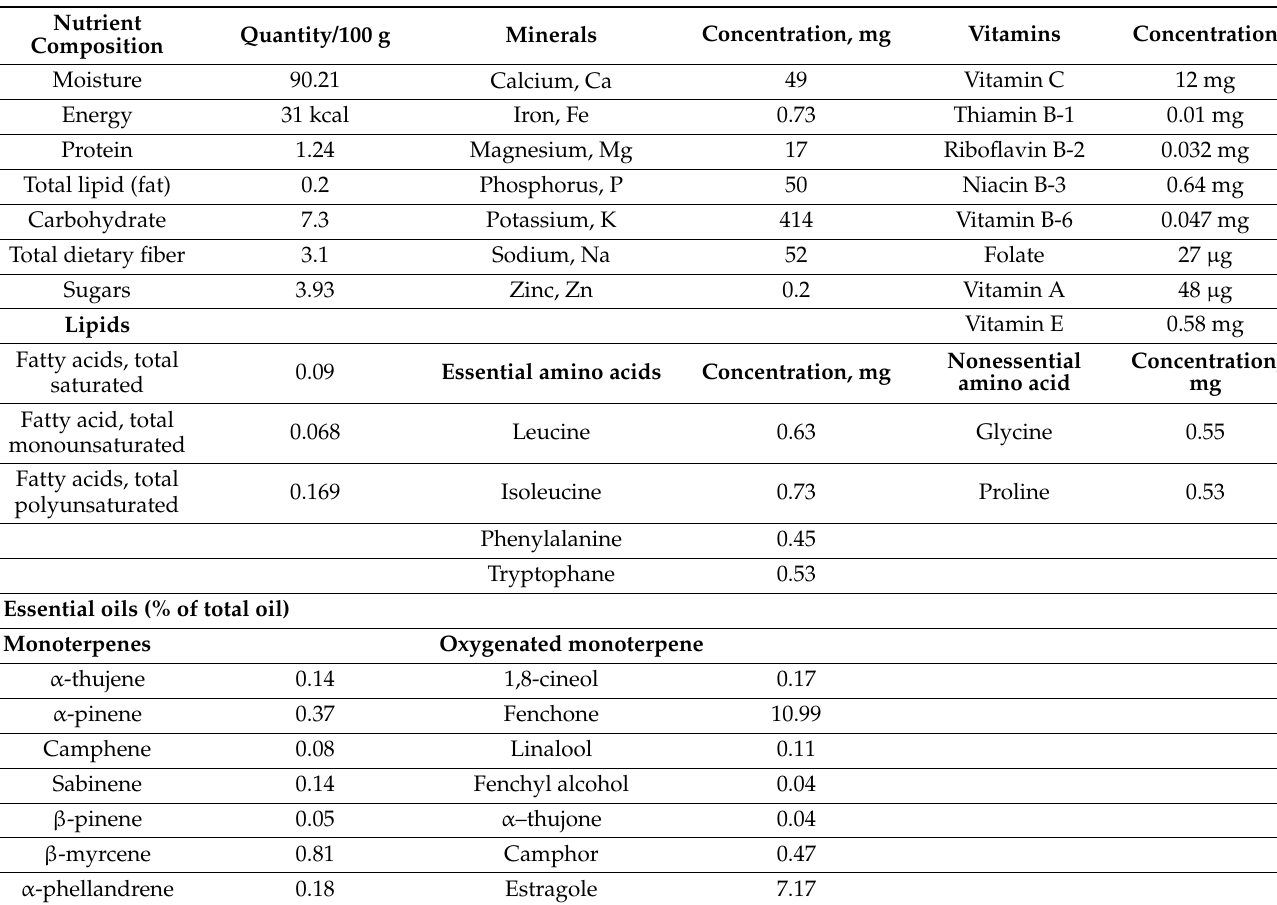
Table 2. Proximate composition and important bioactive constituents in fennel seeds